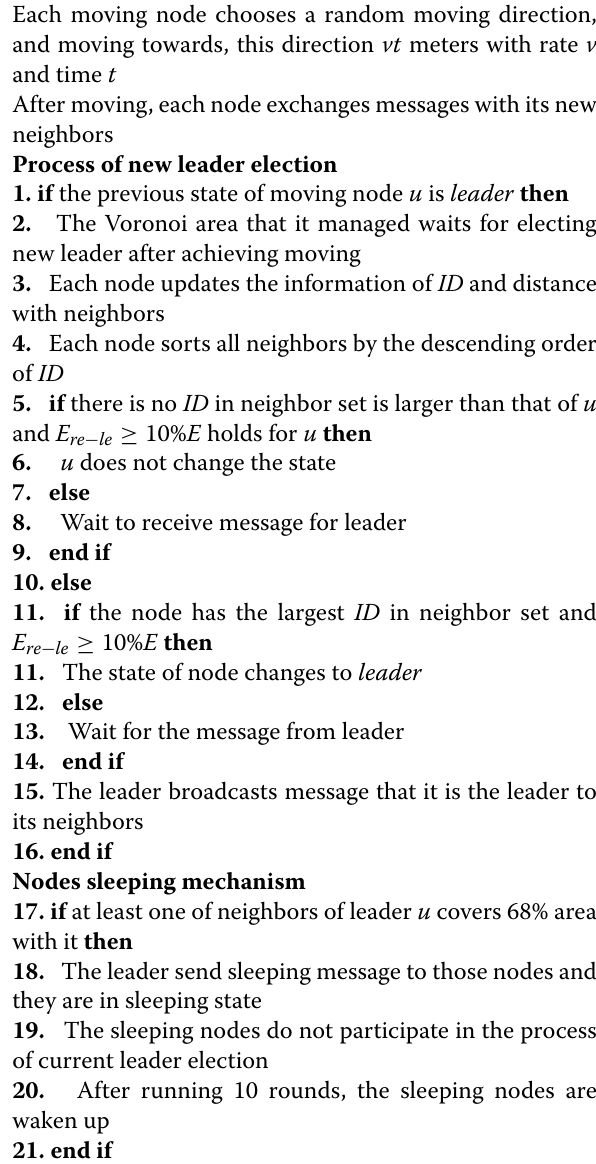
Algorithm 2 Algorithm 2: Node Moving based Distributed Multi-leader Election Algorithm